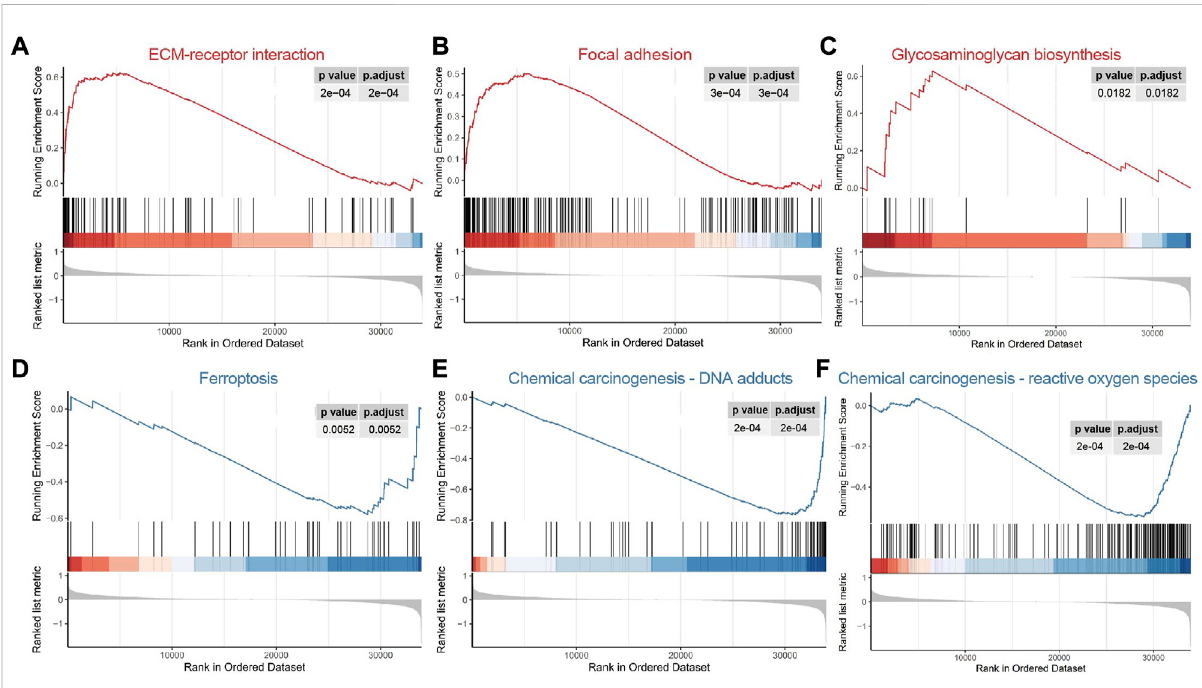
(PDB ID: 2 P FR) had a docking af fi nity score of -6.4 kcal/mol (Figure 8A). Dapsone binds to NAT2 through interacting with amino acid residues, such as glu261, leu275, ser274, gly276, glu264, leu267, asn278, leu279, val263 and glu260. The docking af fi nity score between xanthohumol and LCAT (PDB ID: 4X96) was -7.1 kcal/mol (Figure 8B). Xanthohumol binds